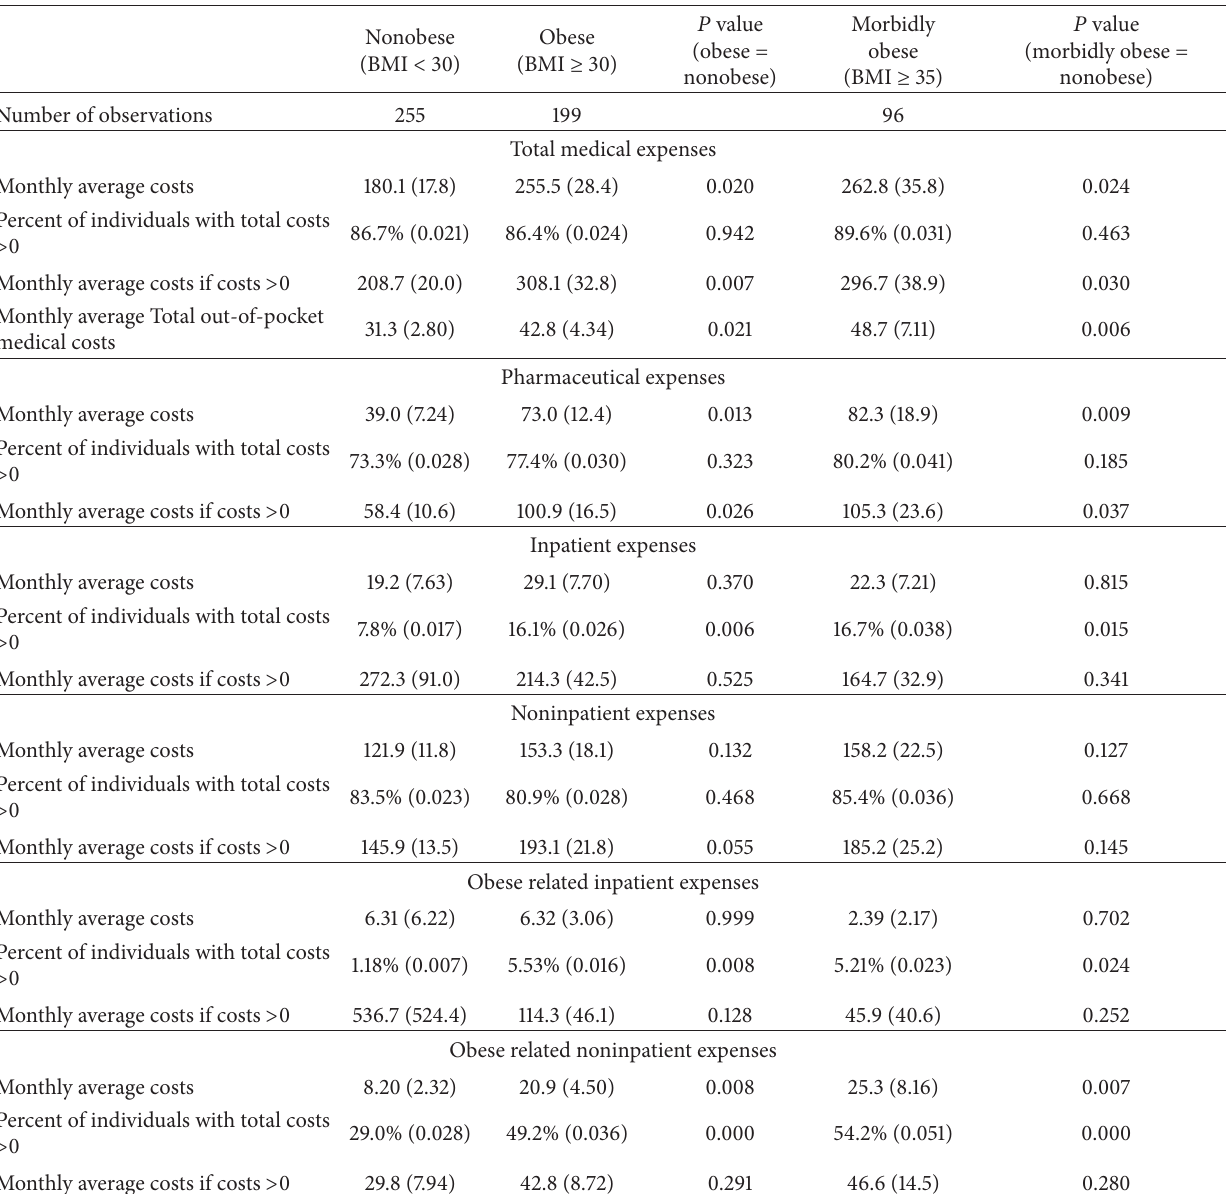
Table 2: Health care expenses of study population (means or % { standard errors } ) by obesity status.